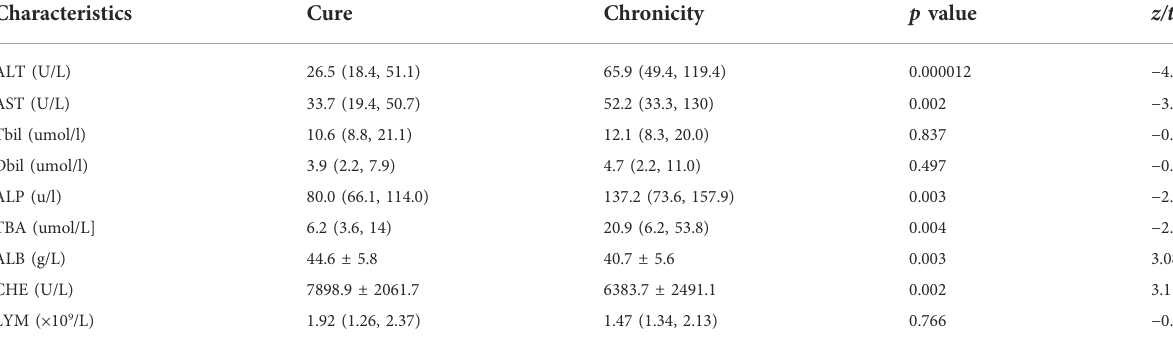
TABLE 2 Comparison of selected characteristics of 6 months due to different prognosis.